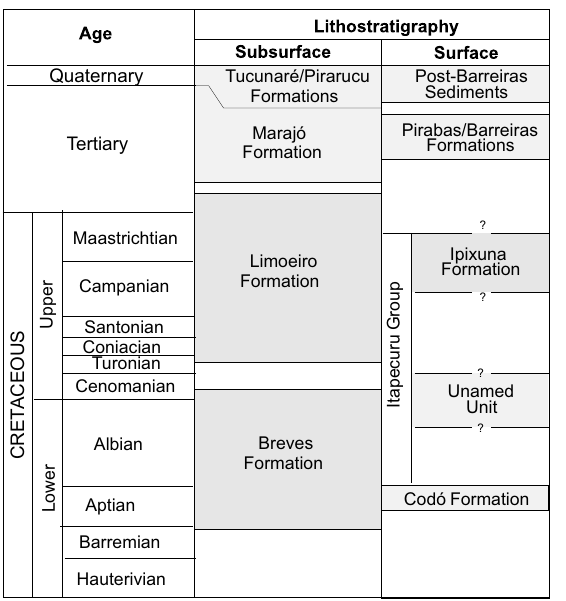
Fig. 2 – Simplified litostratigraphic chart representative of the sedi- mentary sub-basins in the Marajó Graben